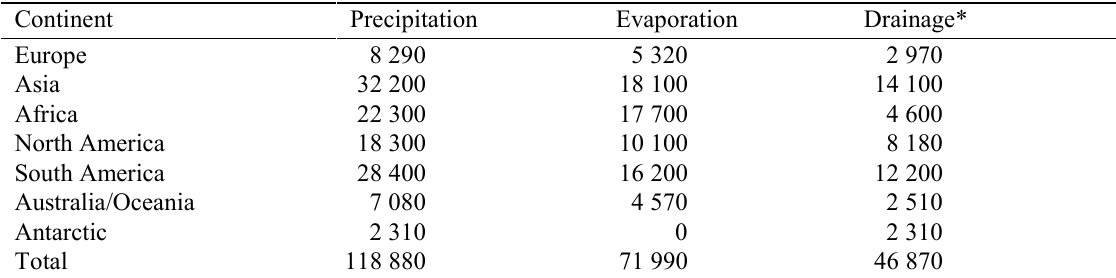
Table 1 Water balance by continent (km 3 /year; source Shikolomanov 1993). Continent Precipitation Evaporation Drainage* Europe 8 290 5 320 2 970 Asia 32 200 18 100 14 100 Africa 22 300 17 700 4 600 North America 18 300 10 100 8 180 South America 28 400 16 200 12 200 Australia/Oceania 7 080 4 570 2 510 Antarctic 2 310 0 2 310 Total 118 880 71 990 46